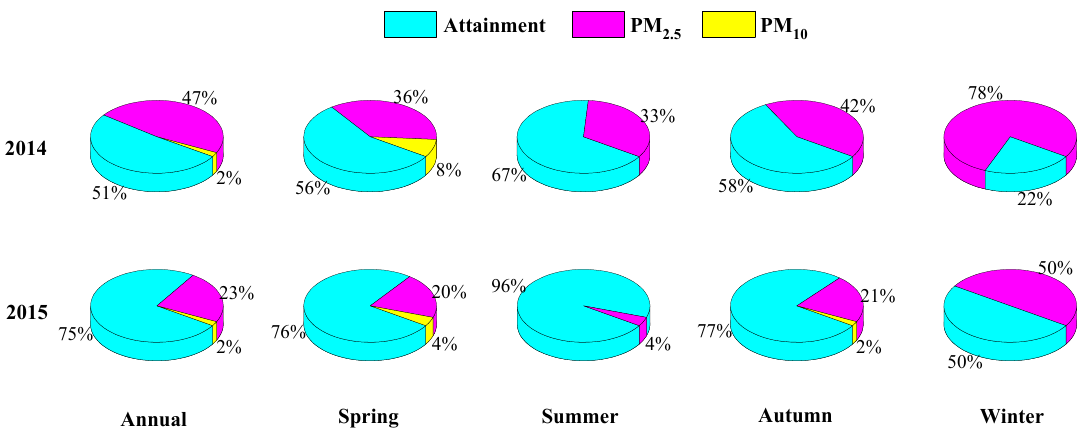
Figure 5. The fractions of major pollutants during 2014 and 2015.